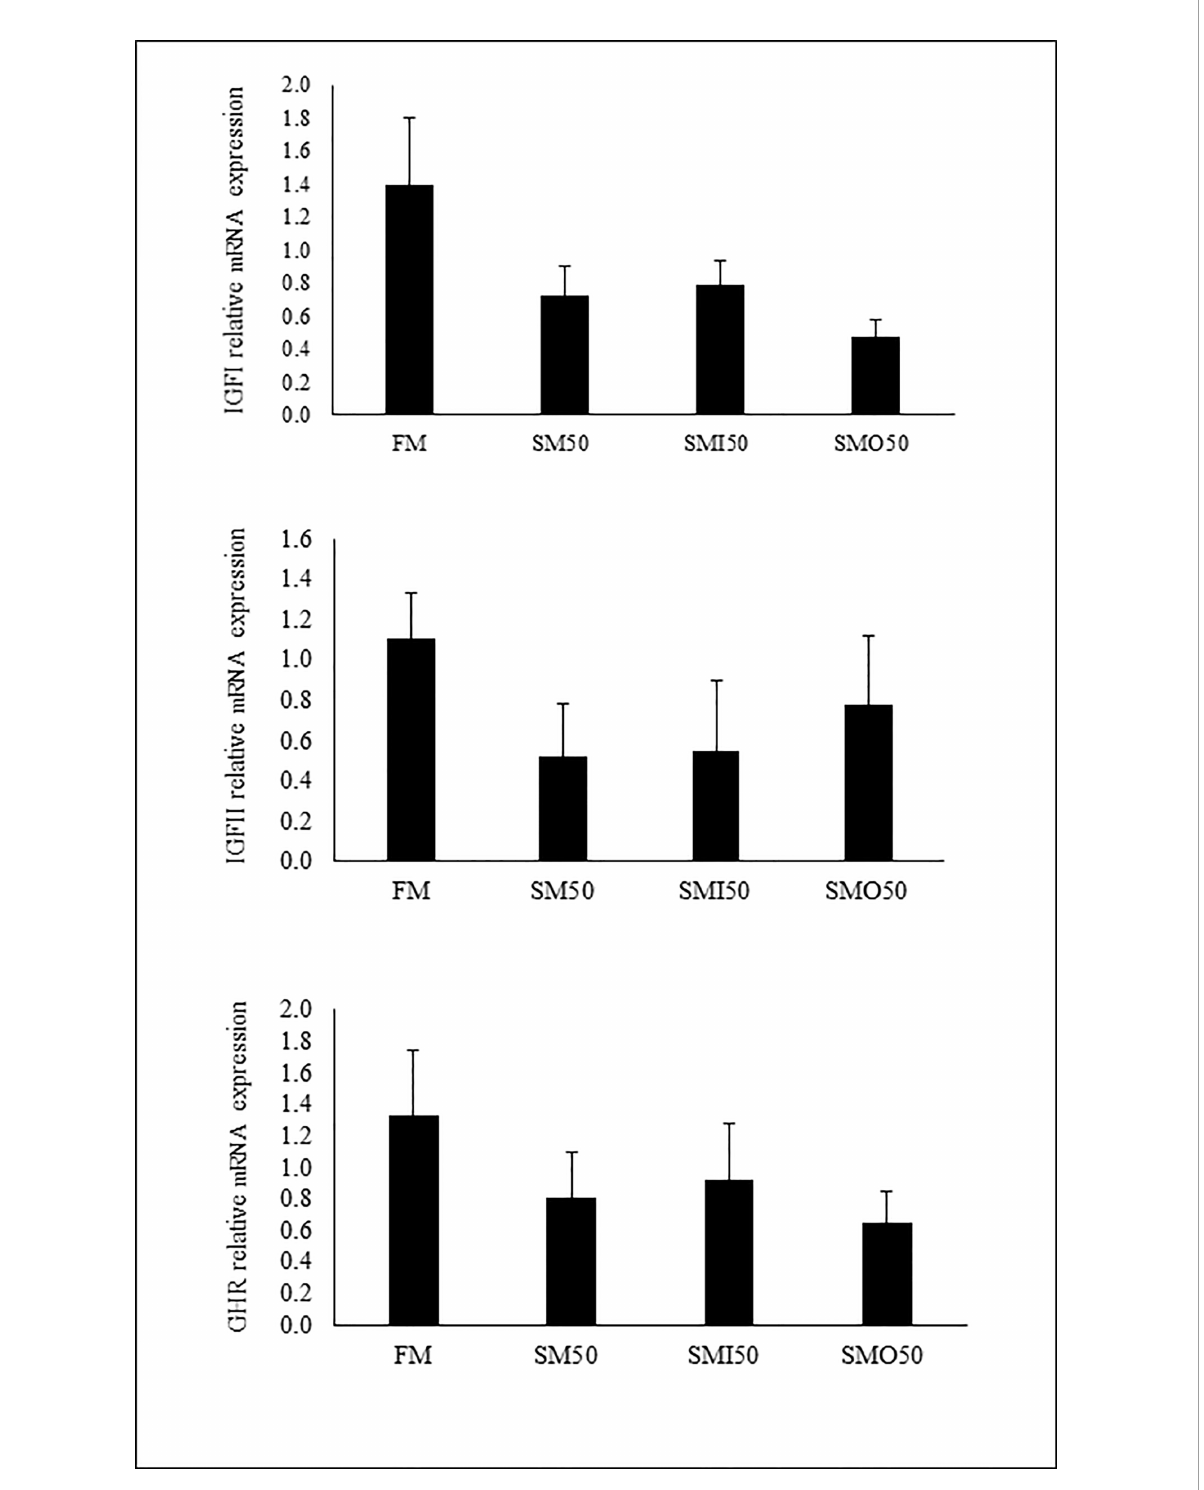
FIGURE 2 Relative mRNA expression in liver of pikeperch fed the experimental diets for 8 weeks of A) IGF-I , B) IGF-II , C) GHR gene. FM (45% crude protein and 12% crude lipid); SM50, by replacing 50% of FM with SM, SMI50, by replacing 50% of FM with SM and inulin addition; SMO50, by replacing 50% of FM with SM and oligofructose addition. The lack of superscript letter indicates no signi fi cant differences (P > 0.05) among